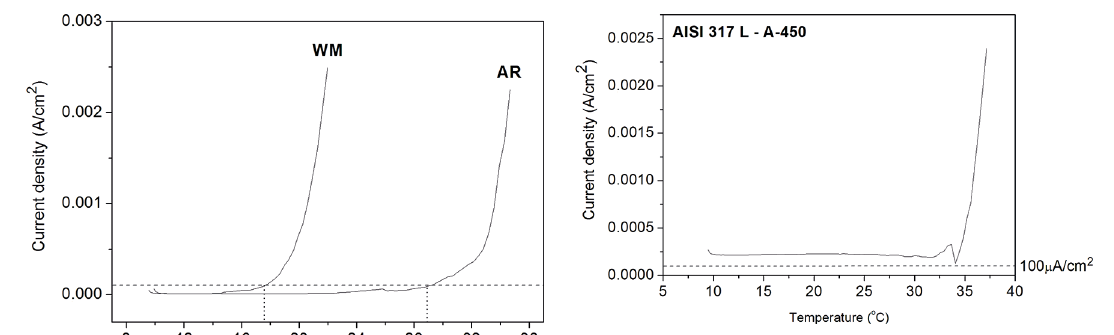
Figure 7. Curve for CPT determination in specimen